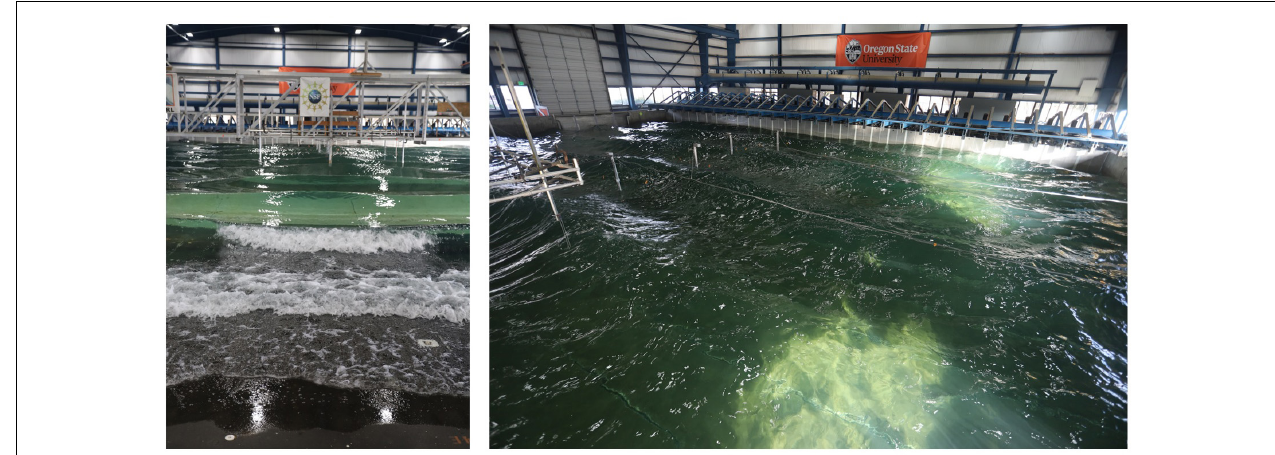
FIGURE 4 | Overview of Directional Wave Basin (left) and wavemaker detail (right) .